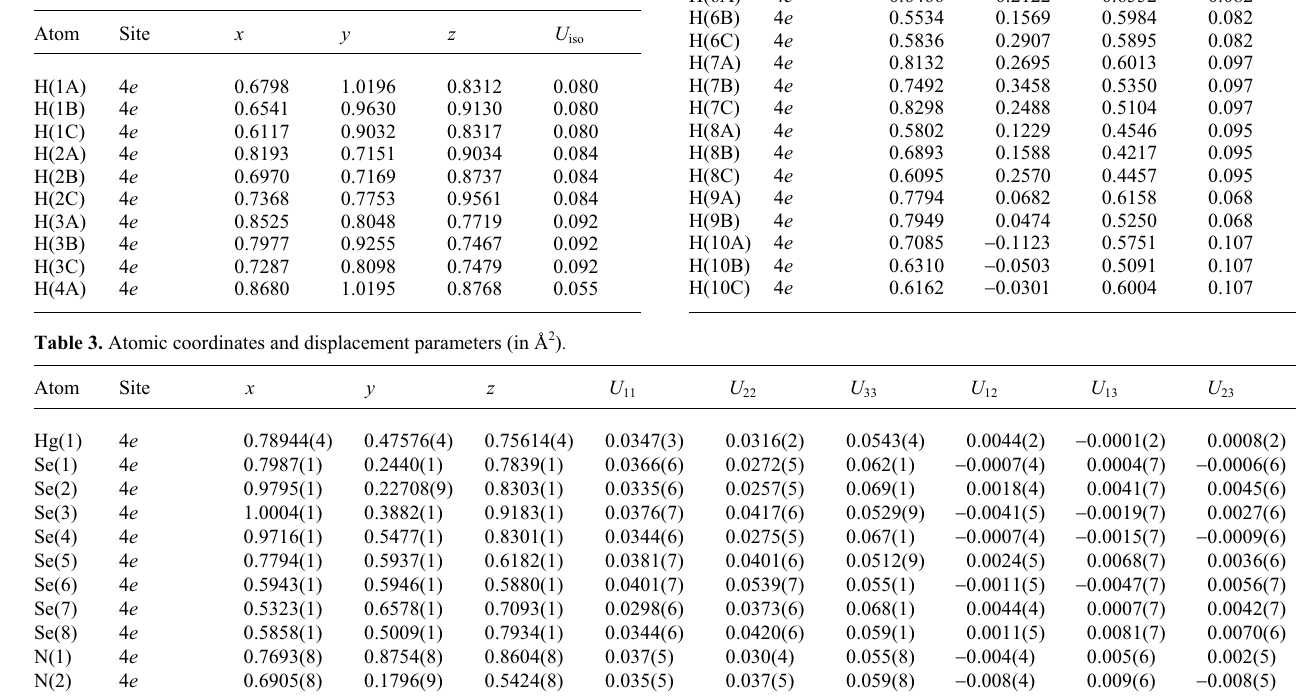
Table 2. Atomic coordinates and displacement parameters (in Å 2 ) .